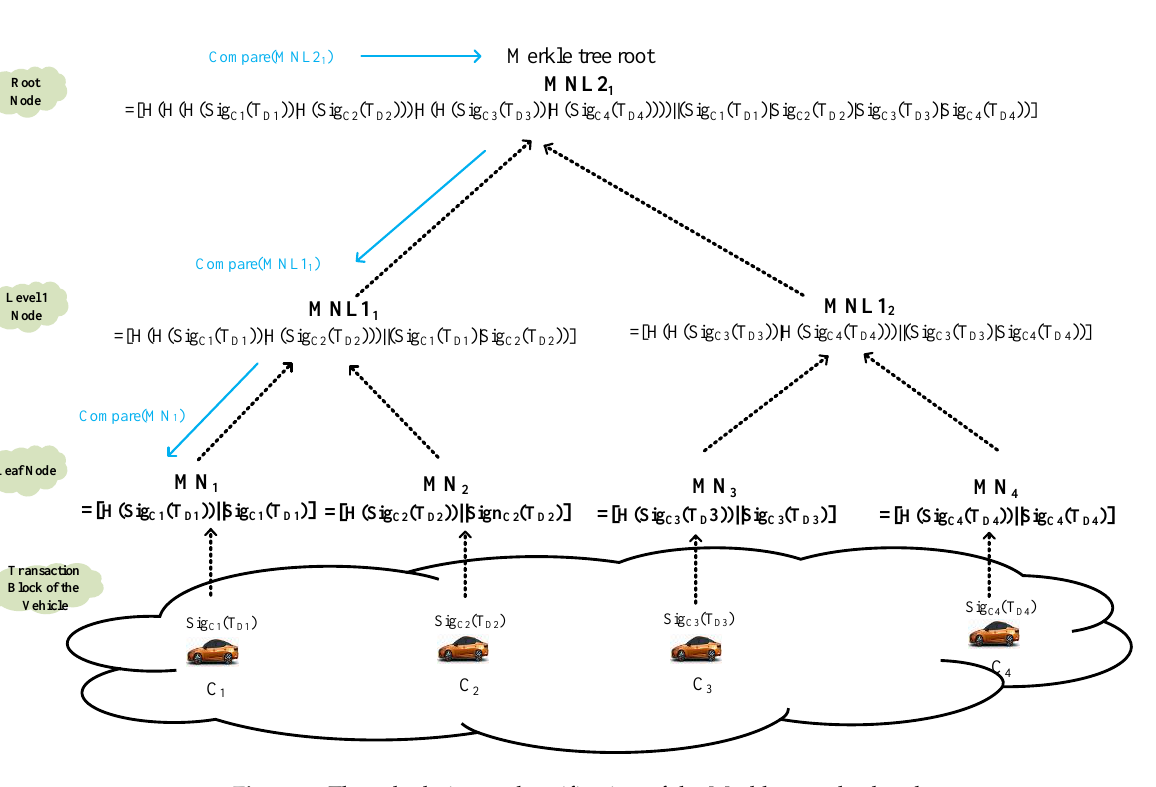
Figure 5. The calculation and verification of the Merklet root hash value.